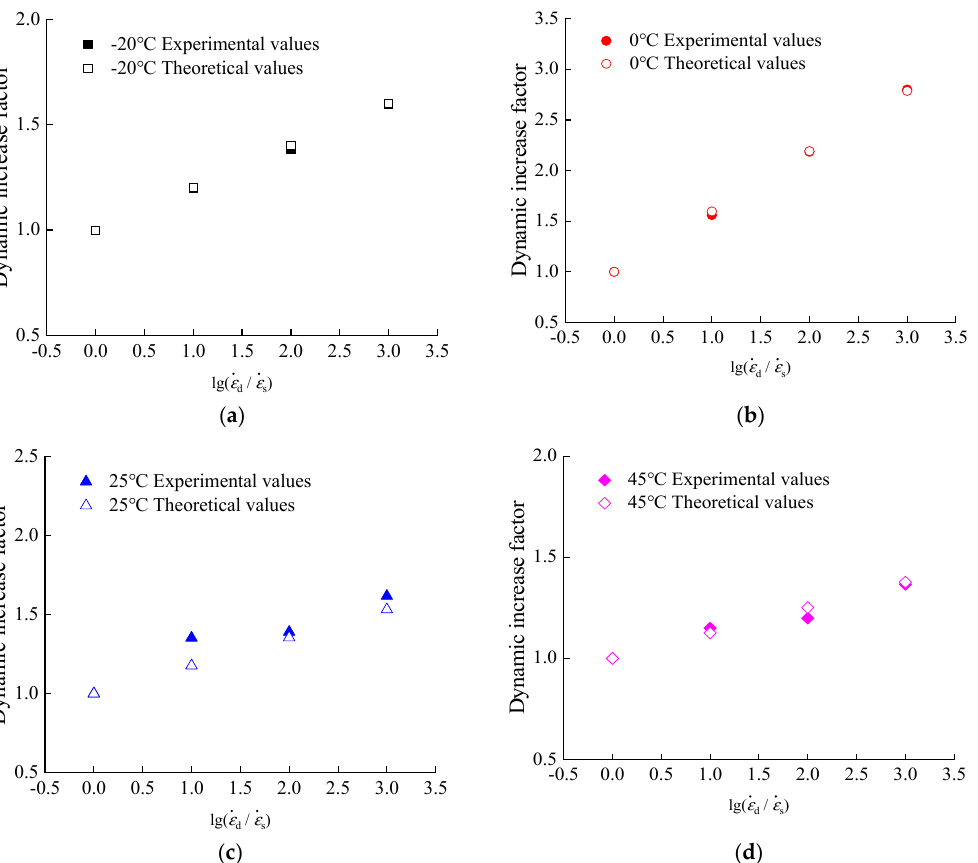
Figure 14. Comparison of theoretical and experimental values of peak compressive stress. ( a ) Figure14. Comparisonoftheoreticalandexperimentalvaluesofpeakcompressivestress. ( a )temperature − 20 ◦ C; ( b ) temperature 0 ◦ C; ( c ) temperature 25 ◦ C; ( d ) temperature 45 ◦ temperature − 20 °C; ( b ) temperature 0 °C; ( c ) temperature 25 °C; ( d ) temperature 45 °C.